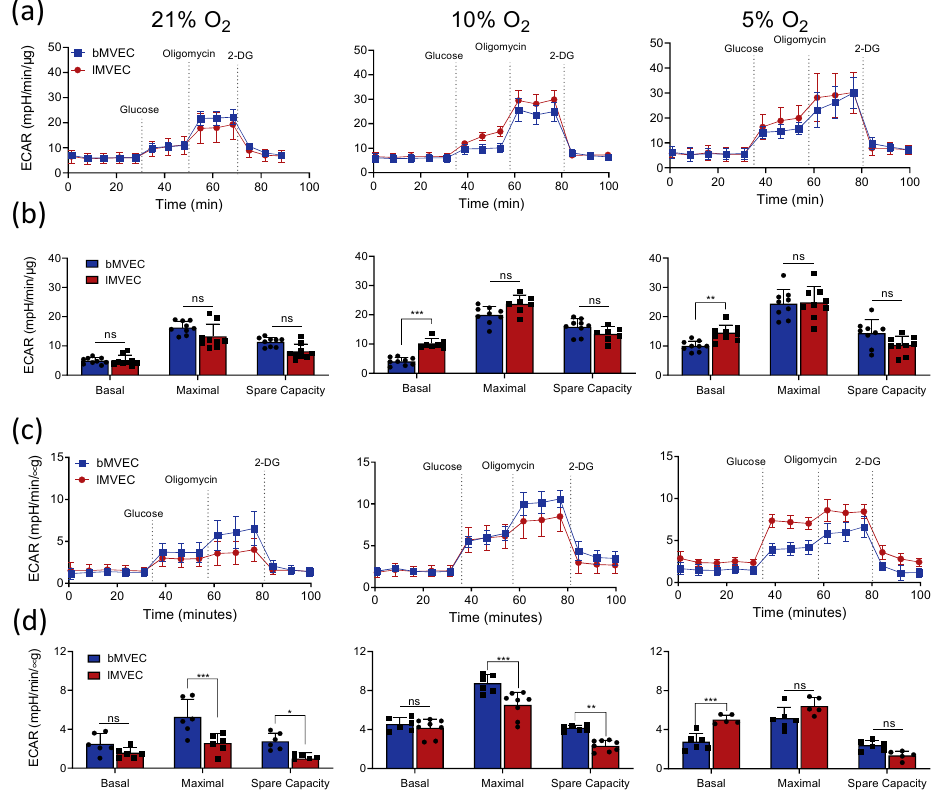
Figure 3. MVEC glycolytic activity is organ-specific and affected by O 2 priming. ( a ) Representative charts of baseline glycolytic stress tests of brain and lung MVEC cultured at 21% O 2 (left), 10% O 2 (middle) or 5% O 2 (right); ( b ) glycolytic parameters calculated from each curve from ( a ) are shown as average ± SD ( n ≥ 4). Statistical analysis was carried out using 2-way ANOVA with Holm–Sidak’s multiple comparison test (** p < 0.01, *** p < 0.001, ns = not significant); ( c ) representative charts of glycolytic stress tests of brain and lung MVEC after 24 h of hypoxia (1% O 2 ) from cells primed at different O 2 . Assays were carried out at 1% O 2 ; ( d ) glycolytic parameters calculated from each curve from ( c ) are shown as average ± SD ( n ≥ 4). Statistical analysis was performed using 2-way ANOVA with Holm–Sidak’s multiple comparison test (* p < 0.05, ** p < 0.01, *** < 0.001, ns = not significant).